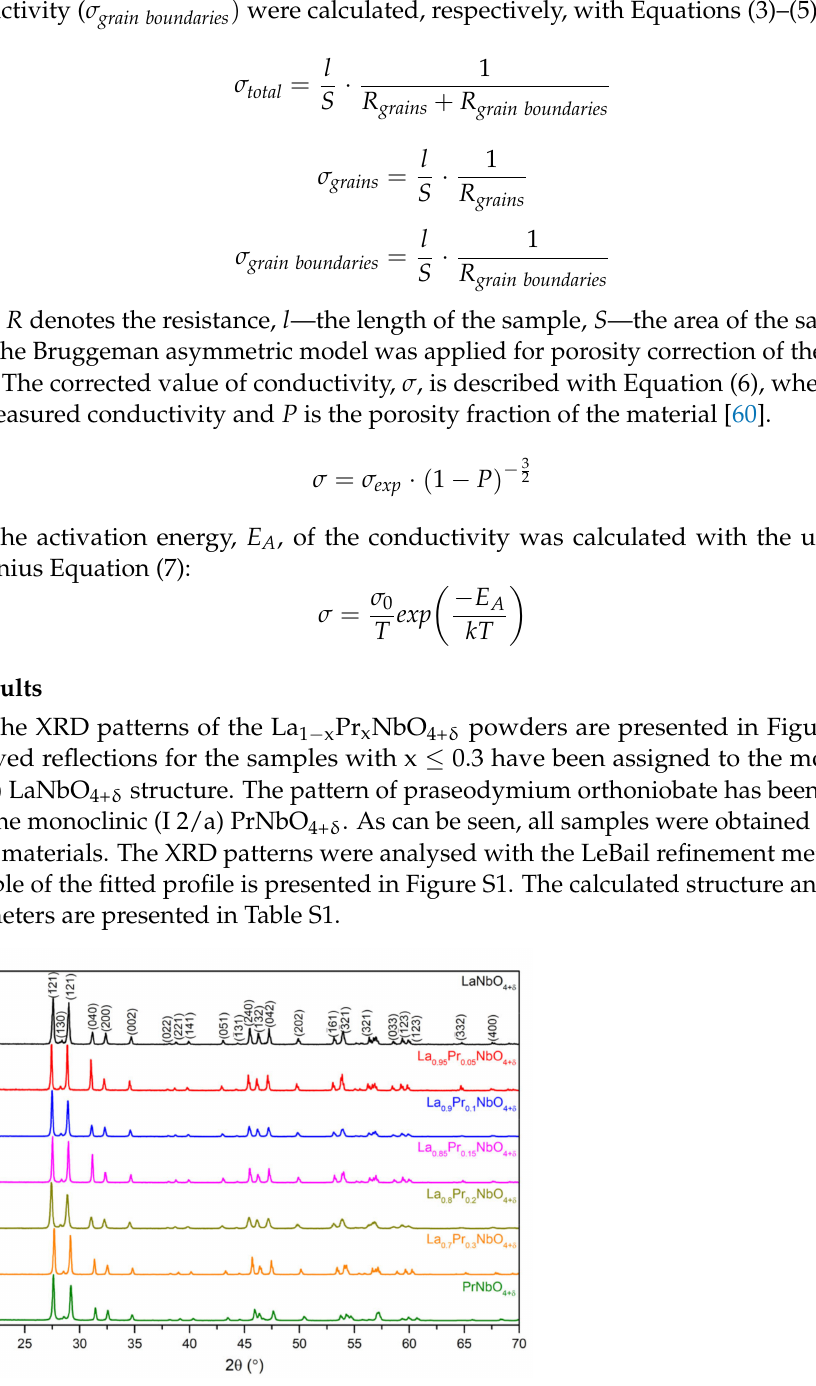
Figure 1. X-Ray diffractograms of the La 1 − x Pr x NbO 4+ δ